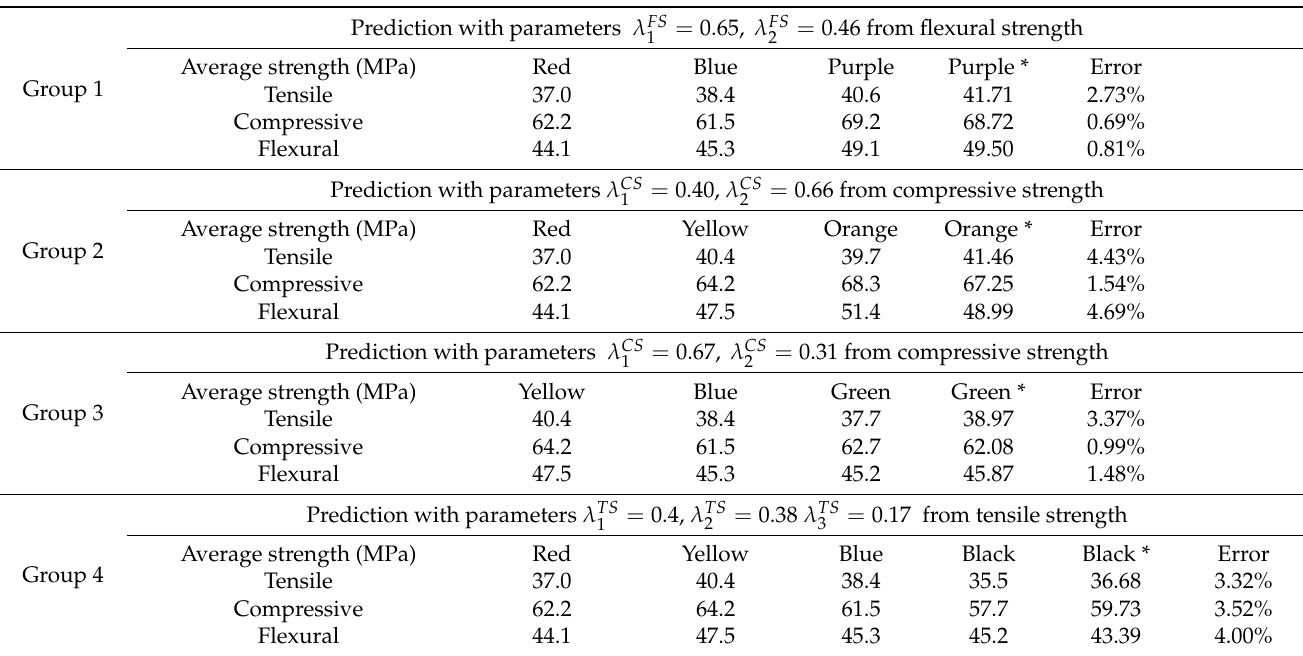
Table 9. Predicated values for mechanical strengths of PLA from Rambery ®